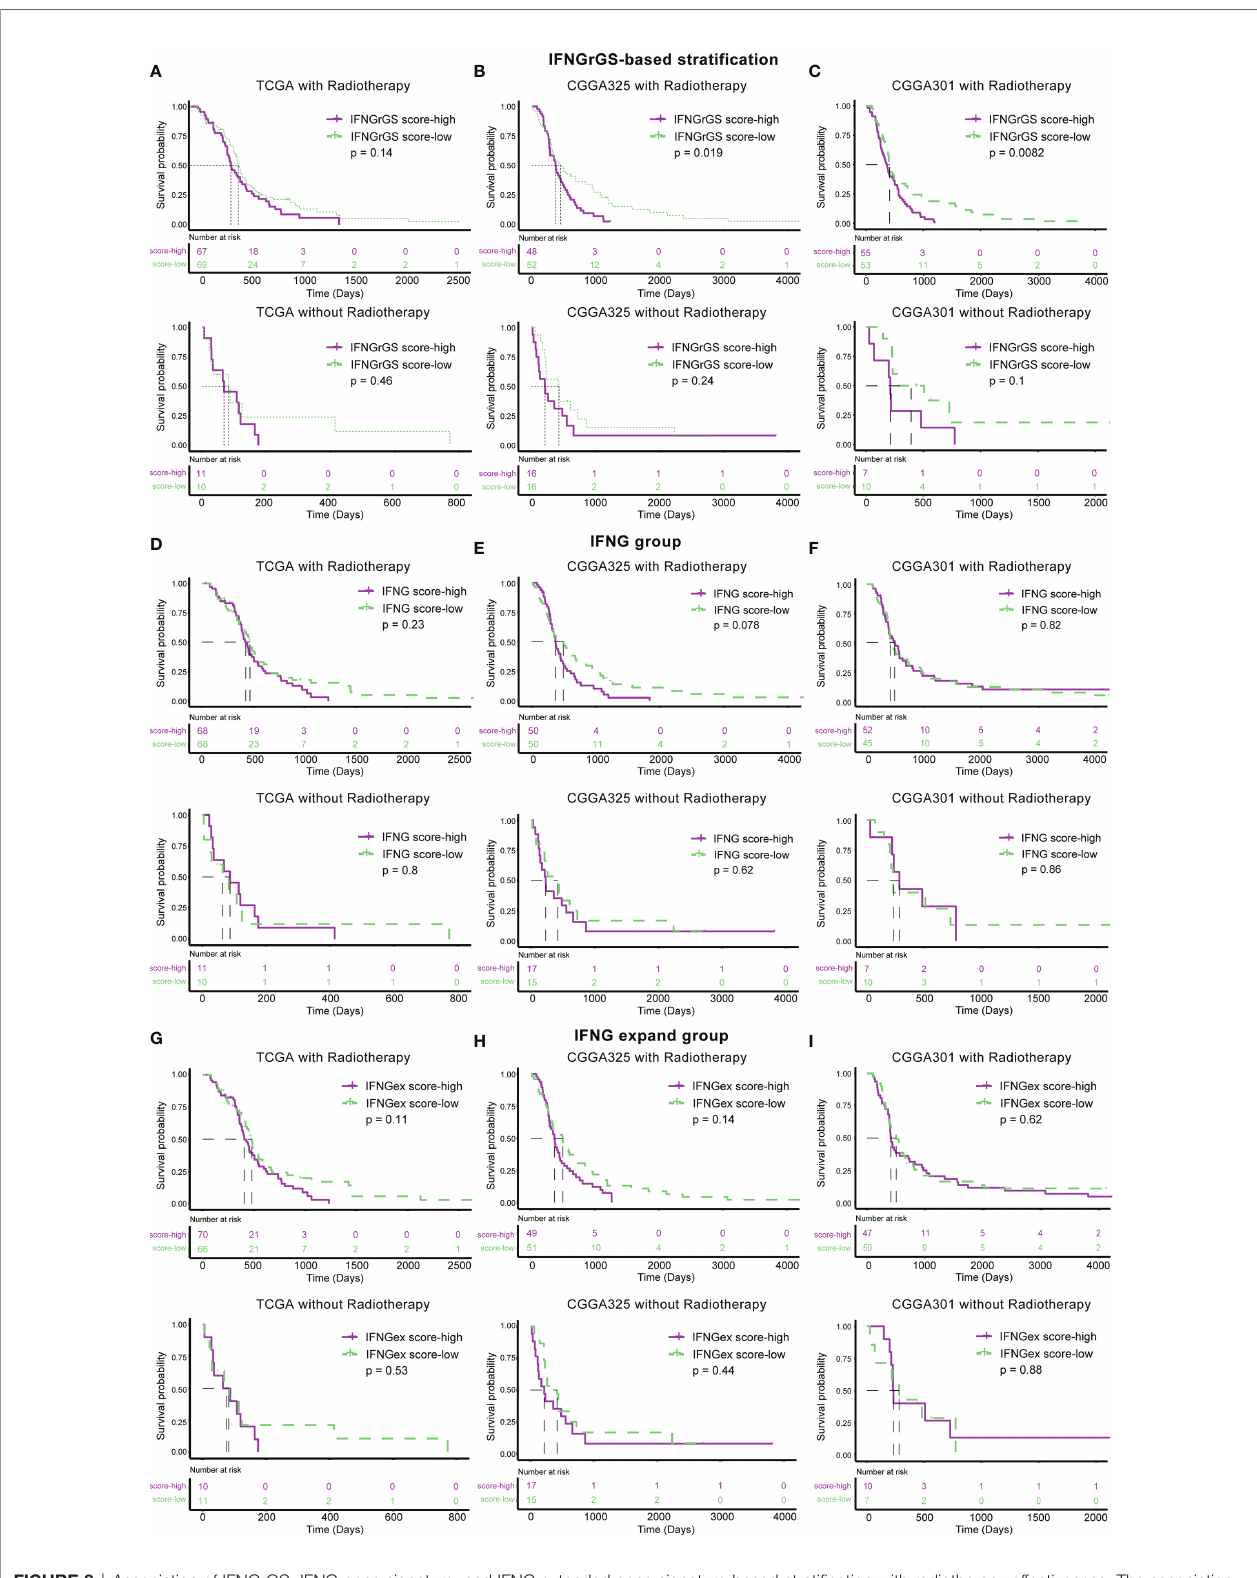
FIGURE 8 | Association of IFNGrGS, IFNG gene signature, and IFNG extended gene signature-based strati fi cation with radiotherapy effectiveness. The association between the IFNGrGS (A – C) , IFNG gene signature (D – F) , and IFNG expand gene signature (G – I) -based strati fi cation and radiotherapy ef fi cacy across 3 data